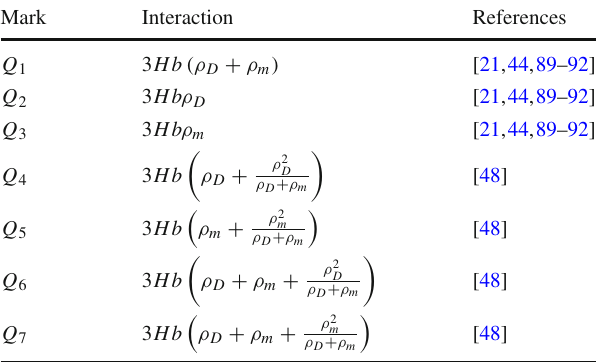
Table 1 List of linear interactions ( Q 1 , 3 ) and non-linear interactions ( Q 4 , 7 ) considered in this